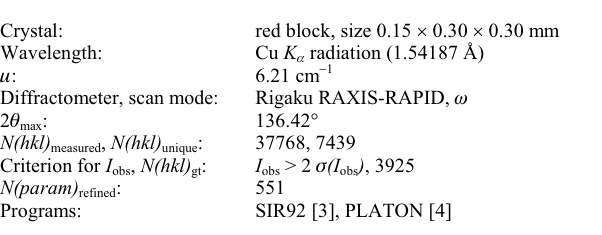
Table 1. Data collection and handling.